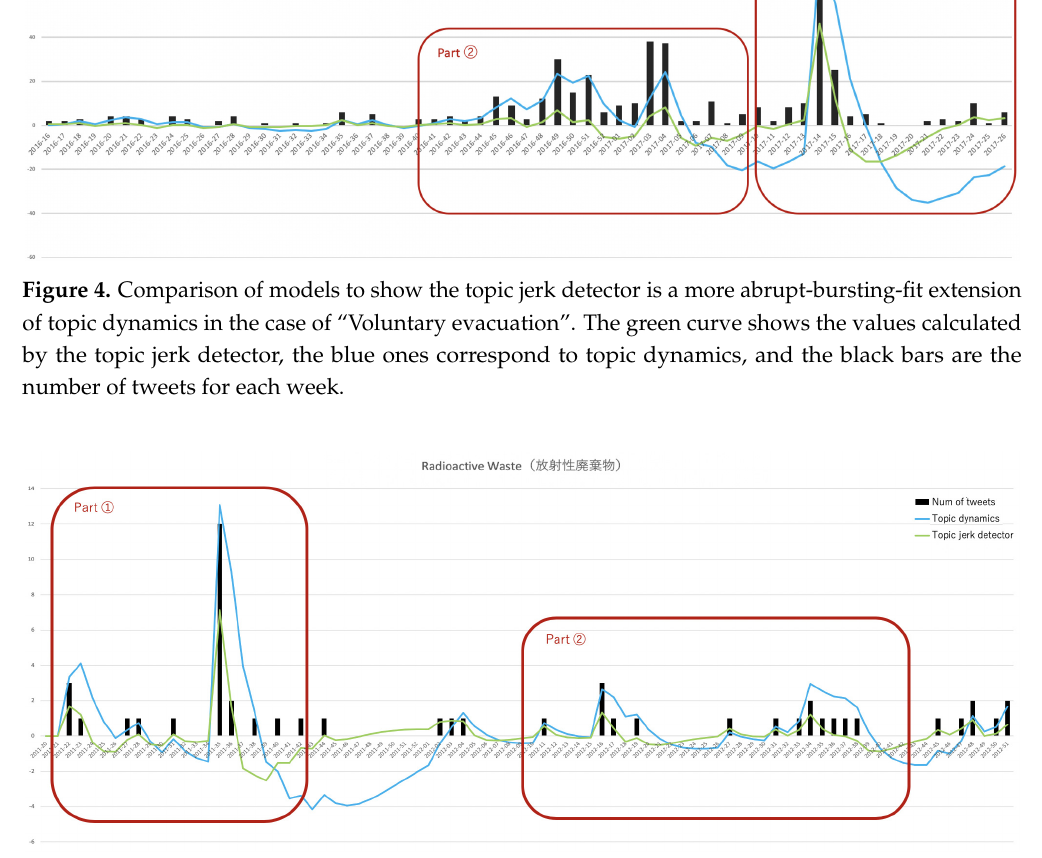
Figure 5. Comparison of models to show the topic jerk detector is a more abrupt-bursting-fit extension of topic dynamics in the case of “Radioactive waste.” The green curve shows the values calculated by the topic jerk detector, the blue ones correspond to topic dynamics, and the black bars are the number of tweets for each